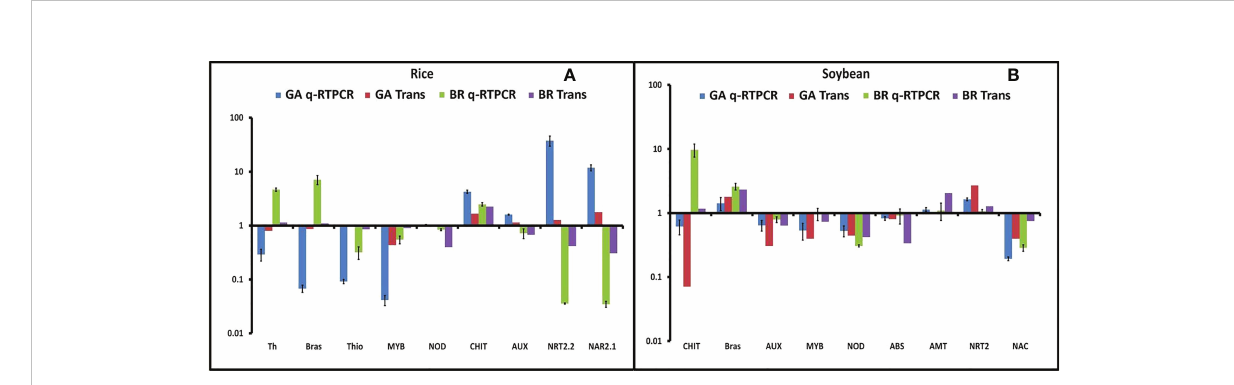
FIGURE 5 Validation of all 12 differentially expressed genes (DEGs). (A) Fold change of all nine selected DEGs in rice was plotted against the qRT-PCR result. (B) Fold change of all nine selected DEGs in soybean was plotted against the qRT-PCR result. Abbreviations: Th, thaumatin; Brs, brassinosteroid receptor; Thi, thionin; NOD, Early Nodulin36A protein; CHI, chitinase; AUX, auxin response factor; NRT, nitrate transporter; NAR, nitrate transport accessory protein.